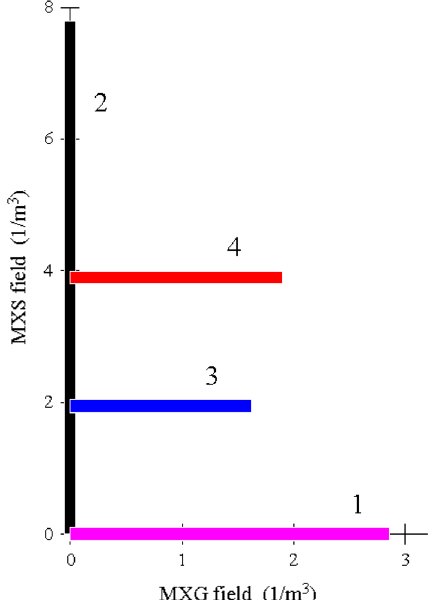
FIG. 7. In this picture of the S × G plane, four bars show the paths of four planned scans of the IPP lifetime. They are labeled “ 1 ” through “ 4 ” for later